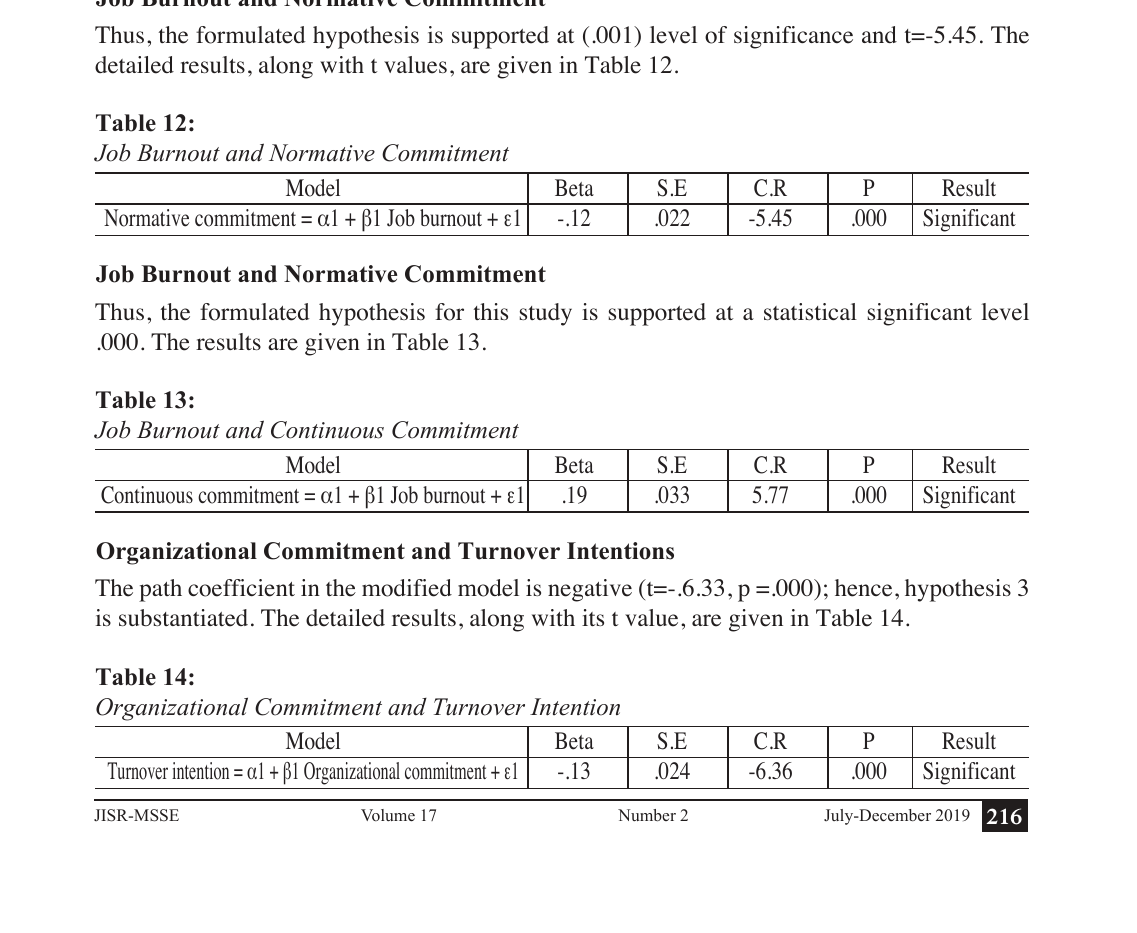
Job Burnout and Normative Commitment